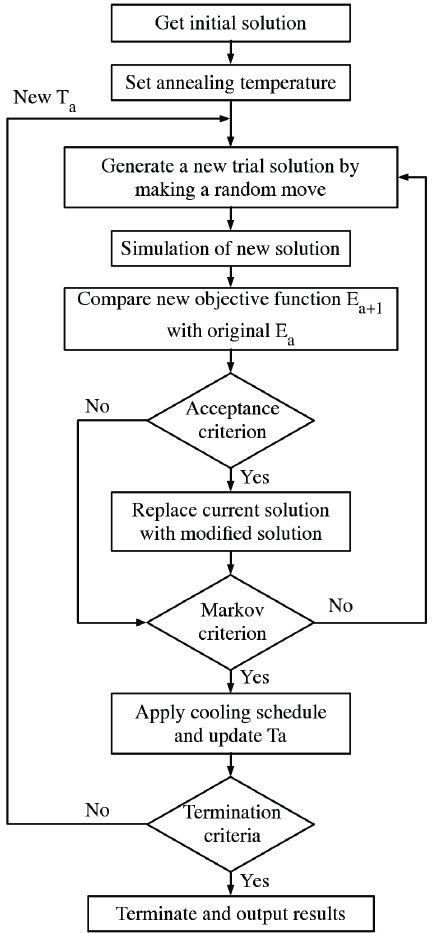
Figure 4. Flow chart of the simulated annealing optimization